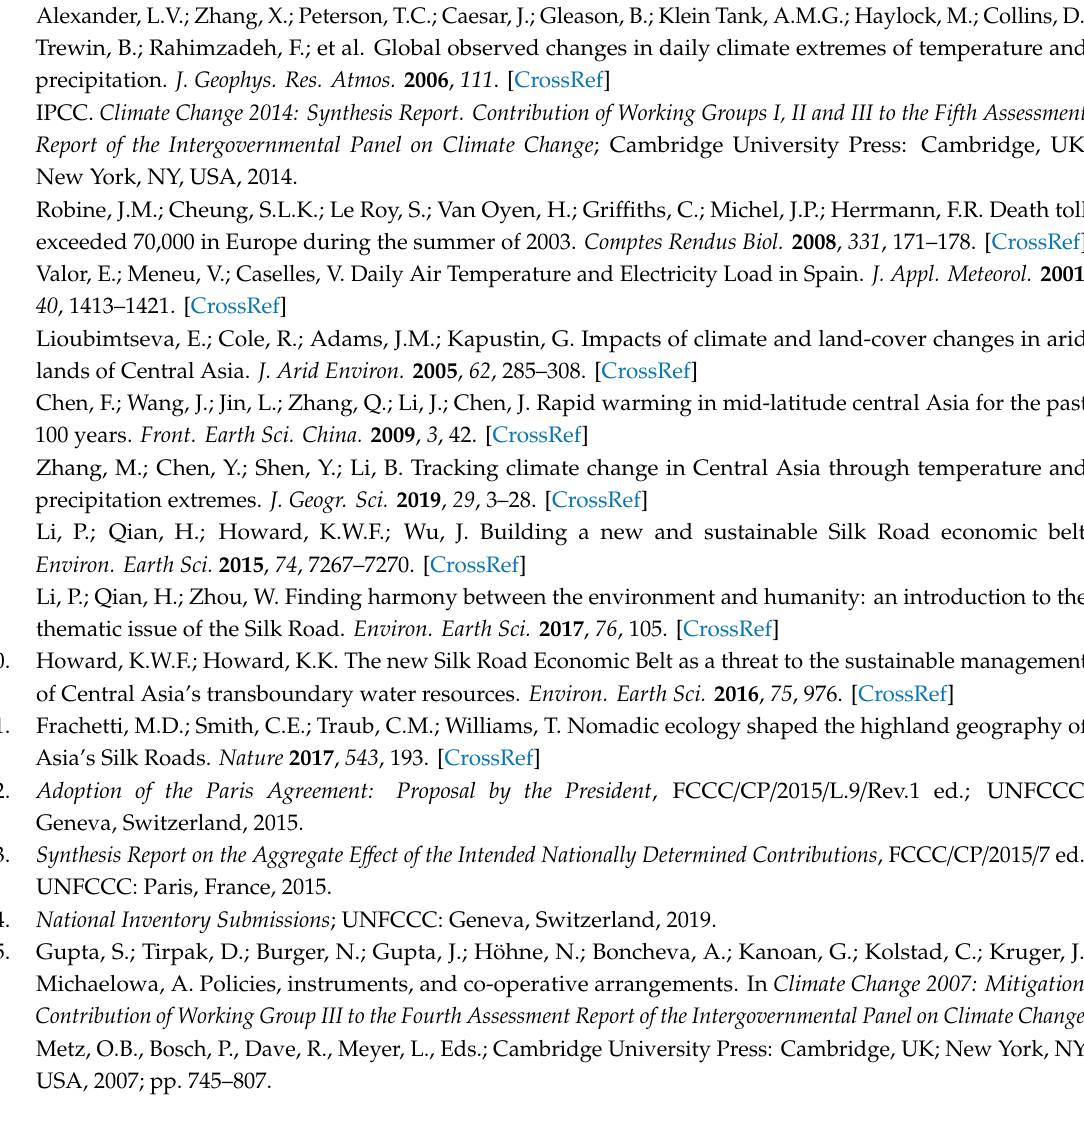
Figure S5: Changes in TX90p (column I), TN90p (column II), and WSDI (column III) over Central Asia, based on multi-model ensemble mean. The di ff erences between di ff erent sets of scenarios are labeled on the top-left. The dotted areas are statistically significant at the 5% level according to Wilcoxon’s rank-sum test, Figure S6: Changes of extreme high-temperature events avoided over Central Asia and its subregions in less warming scenarios (units: percentage). Regional average extreme temperature indices are reduced in the low warming scenarios (left—2.0 ◦ C compared to INDC pledge, right—1.5 ◦ C compare to INDC pledge). The red boxes represent the indices defined by intensity, the yellow boxes represent the indices defined by duration, and the blue boxes represent the indices defined by frequency. Central lines and bars denote multimodal medians and interquartile ranges,